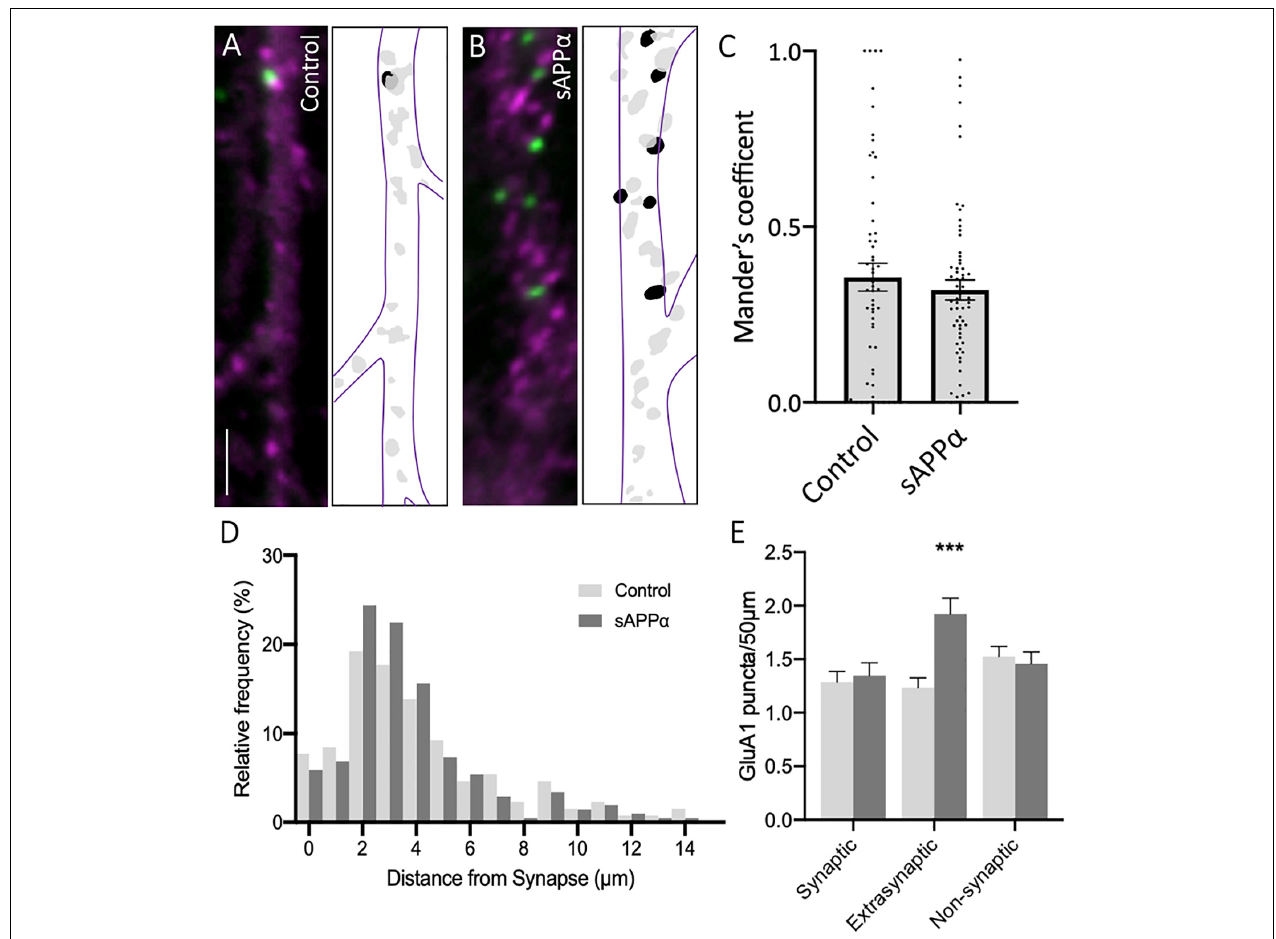
FIGURE 3 | Secreted amyloid precursor protein-alpha enhances de novo GluA1 at the extrasynaptic membrane. Representative images showing de novo cell-surface GluA1 in (A) control and (B) sAPP α -treated conditions. Representative images show dendrites (50 µ m; synapsin-1, (cid:4) ; GluA1, (cid:4) ). Scale bar = 10 µ m. (C) No significant difference was observed in the Mander’s overlap coefficient following sAPP α -treatment (1 nM, 30 min; n = 20 cells, 58–65 dendrites). Significance was assessed by Mann-Whitney two-tailed U-test. (D) Frequency histogram of the distribution of de novo GluA1 puncta in relevance to synapsin-1 immunofluorescence. Distances were calculated for individual PLA puncta with respect to the closest synapsin-1 center of mass. Synaptic PLA showed overlapping centers within 0–2 µ m, puncta within 2–4 µ m were considered extrasynaptic, and puncta beyond 4 µ m were considered non-synaptic ( n = 58–65 dendrites, 130–205 puncta). (E) Quantification of GluA1 puncta abundance at the synaptic, extrasynaptic, and non-synaptic membrane ( n = 58–65 dendrites, 130–205 puncta). Normality was determined by Shapiro-Wilk normality test. All data are expressed relative to control, as mean ± SEM from 3 experiments. Significance